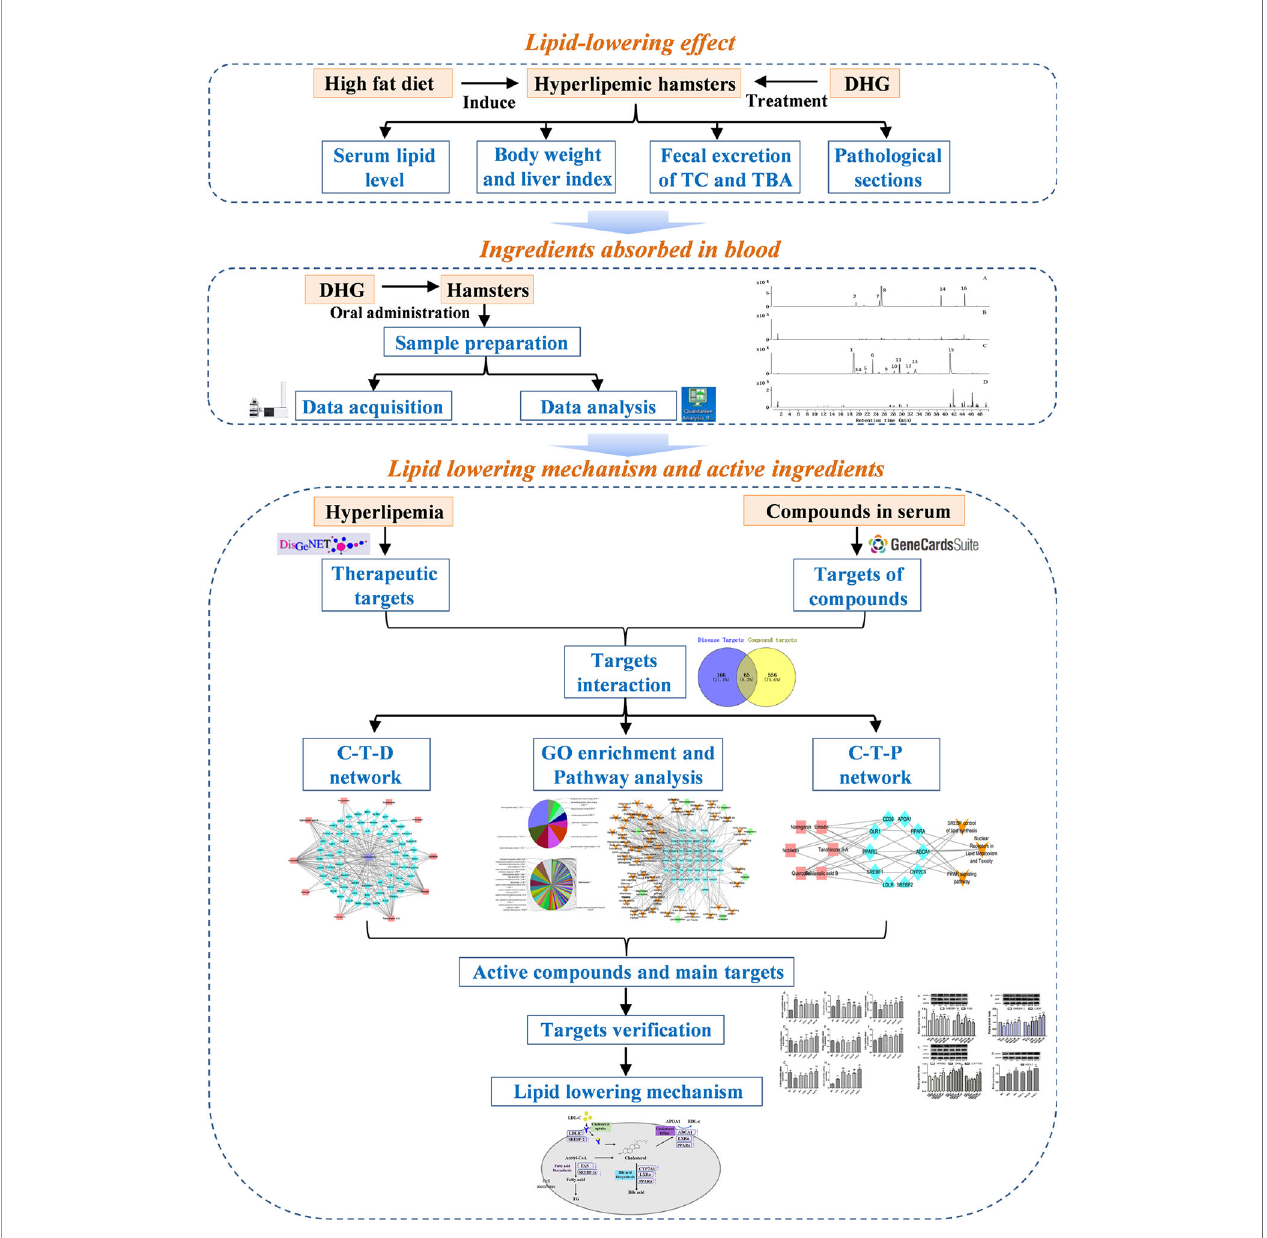
FIGURE 1 | The scheme of investigating the lipid-lowering mechanism and active ingredients of DHG based on systems pharmacology. DHG, Danhe